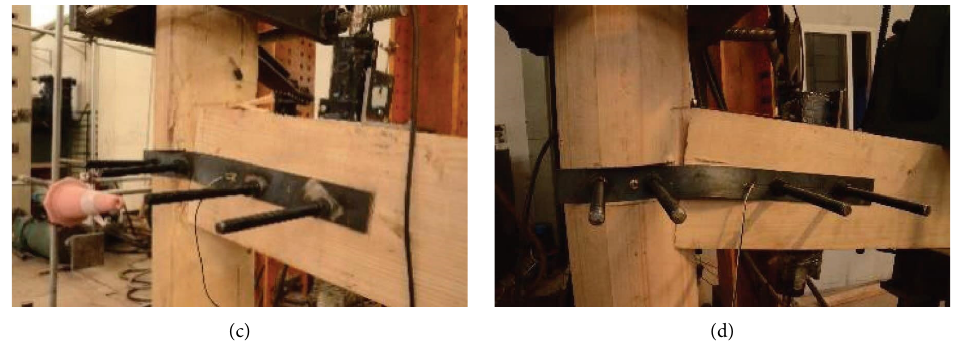
Figure 7: Damage pattern of steel plate reinforced specimens: (a) deformation of the concave mortise of JD-2a. (b) Curving and de- formation of the fat steel strip on JD-2a. (c) Abscission of wood timber of JD-2b. (d) Abscission of wood timber of JD-2c.